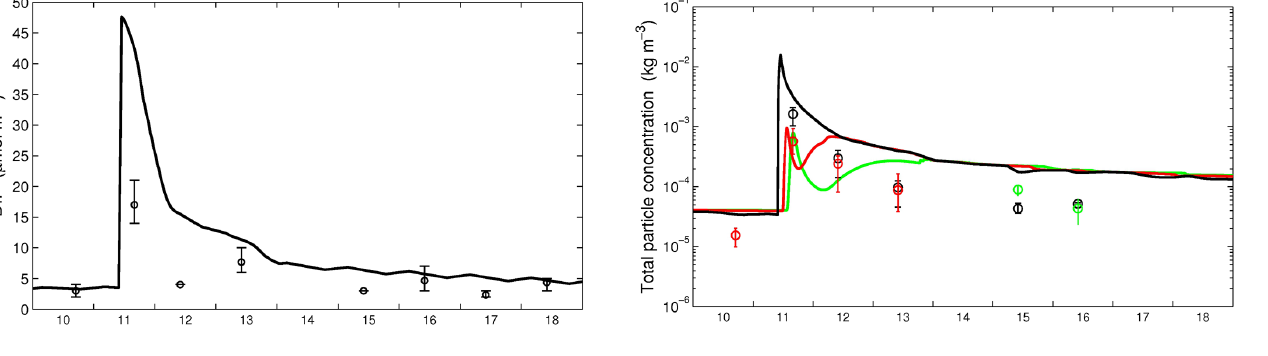
Fig. 6. Modelled (curve) and measured (circle) surface DIP concen- tration in DUST-meso. Error bars show the total range of measured data.